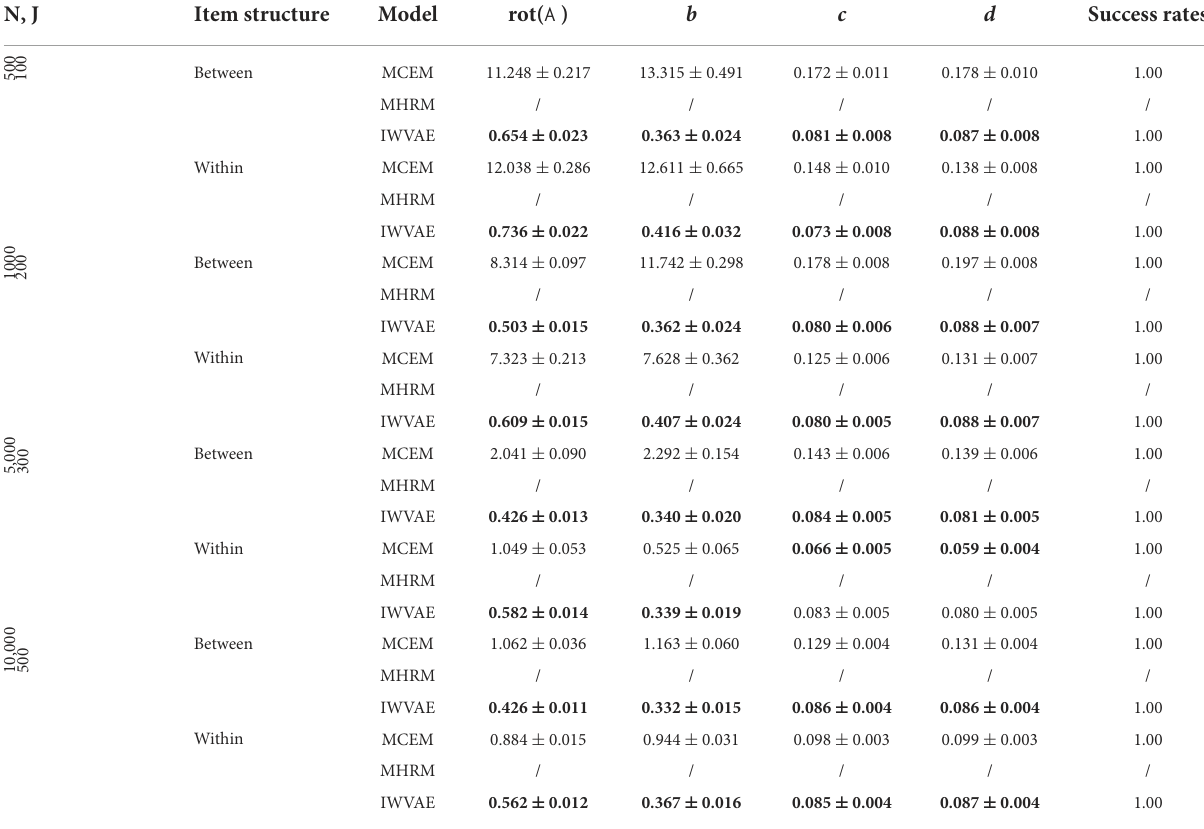
TABLE 6 Mean and SE of RMSE of M p estimate on M4PL models under double regime setting, best results are in bold. N, J Item